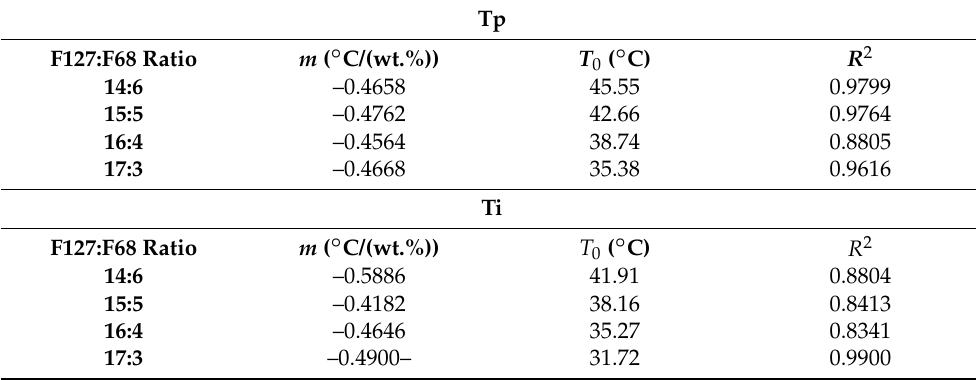
Table 1. Linear regression of the obtained transition temperatures according to microparticle concen- tration (wt.%). Left table for Tp and right table for Ti. m is the slope of the regression and T 0 is the intercept, i.e., the modeled temperature with 0